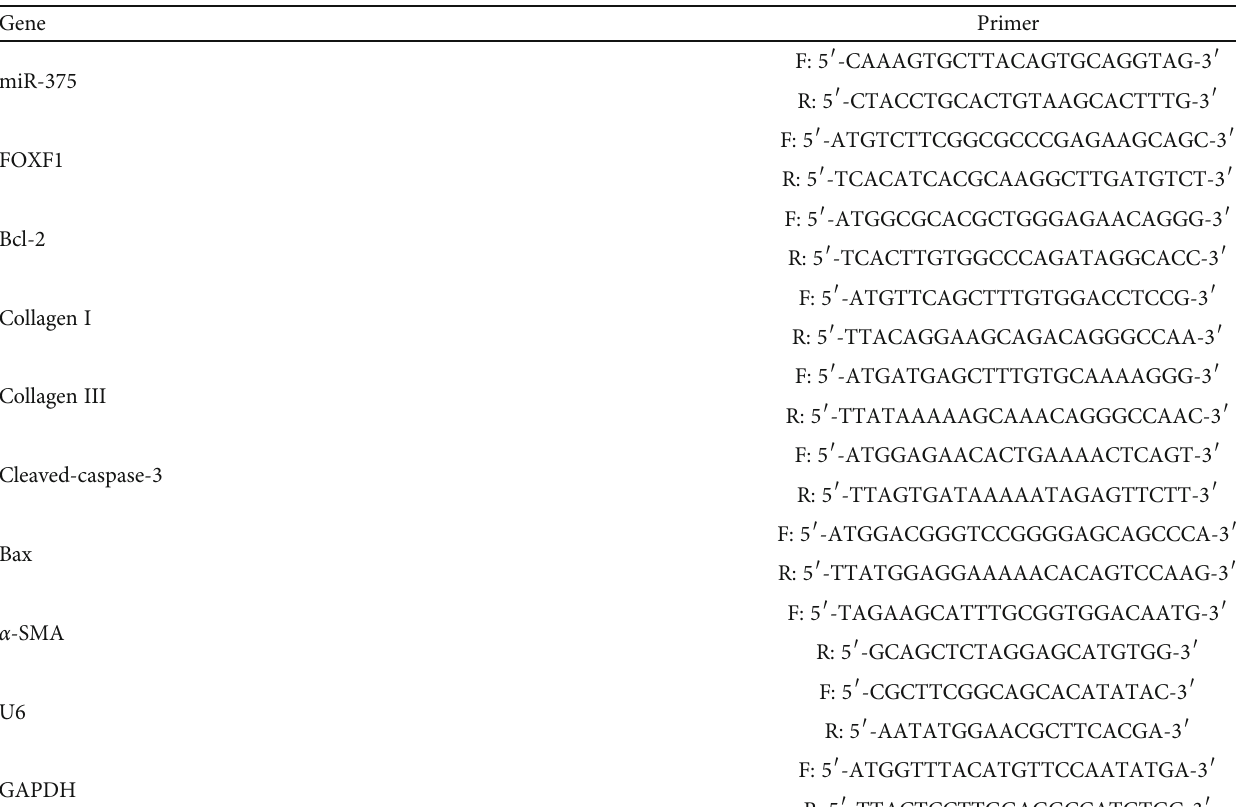
Table 1: Primer sequences for